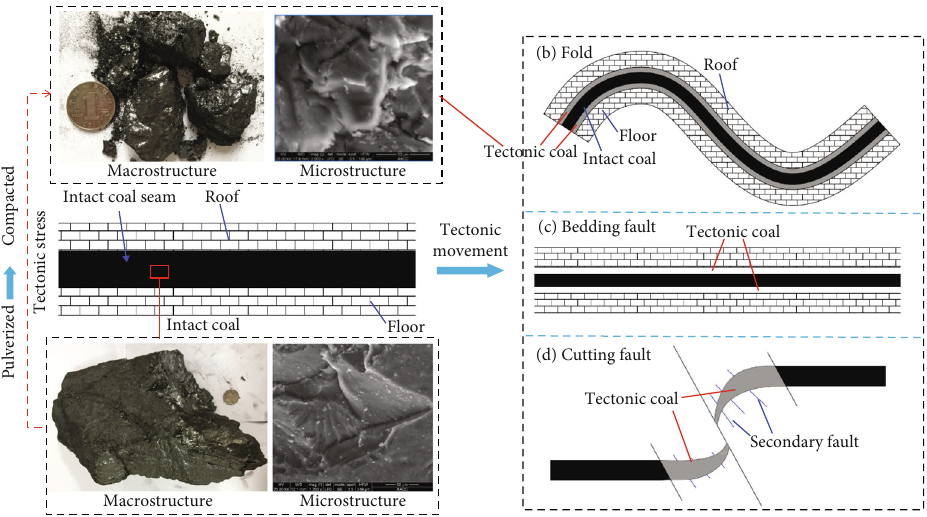
Figure 1: Physical restricting of the intact coal seam under tectonic e ff ect